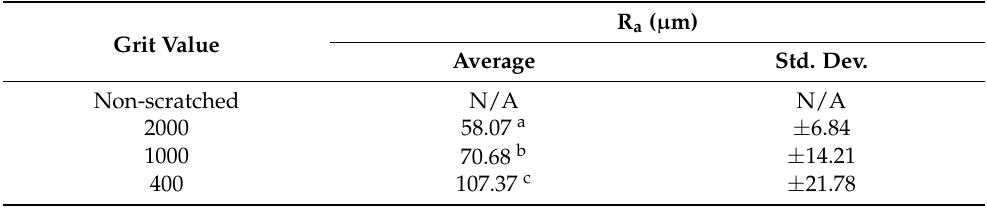
Table 1. Measured surface roughness R a of microscope slide glass samples depending on different grit values of sandpaper were listed. a–c Different letters indicate a significant difference ( p < 0.05).